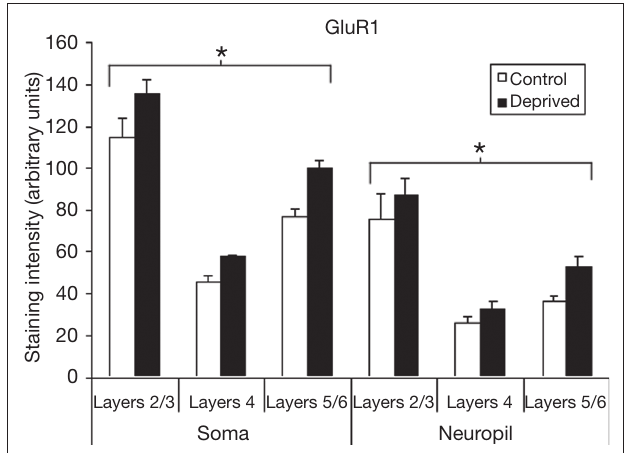
FIGURE 4 | Comparison of average staining intensities for GluR2/3 in deprived and control hemispheres. Conventions are the same as in Figure 2. GluR2/3 staining intensities are lower in the deprived hemisphere in all layers for both cell body and neuropil measurements (* p < 0.001).